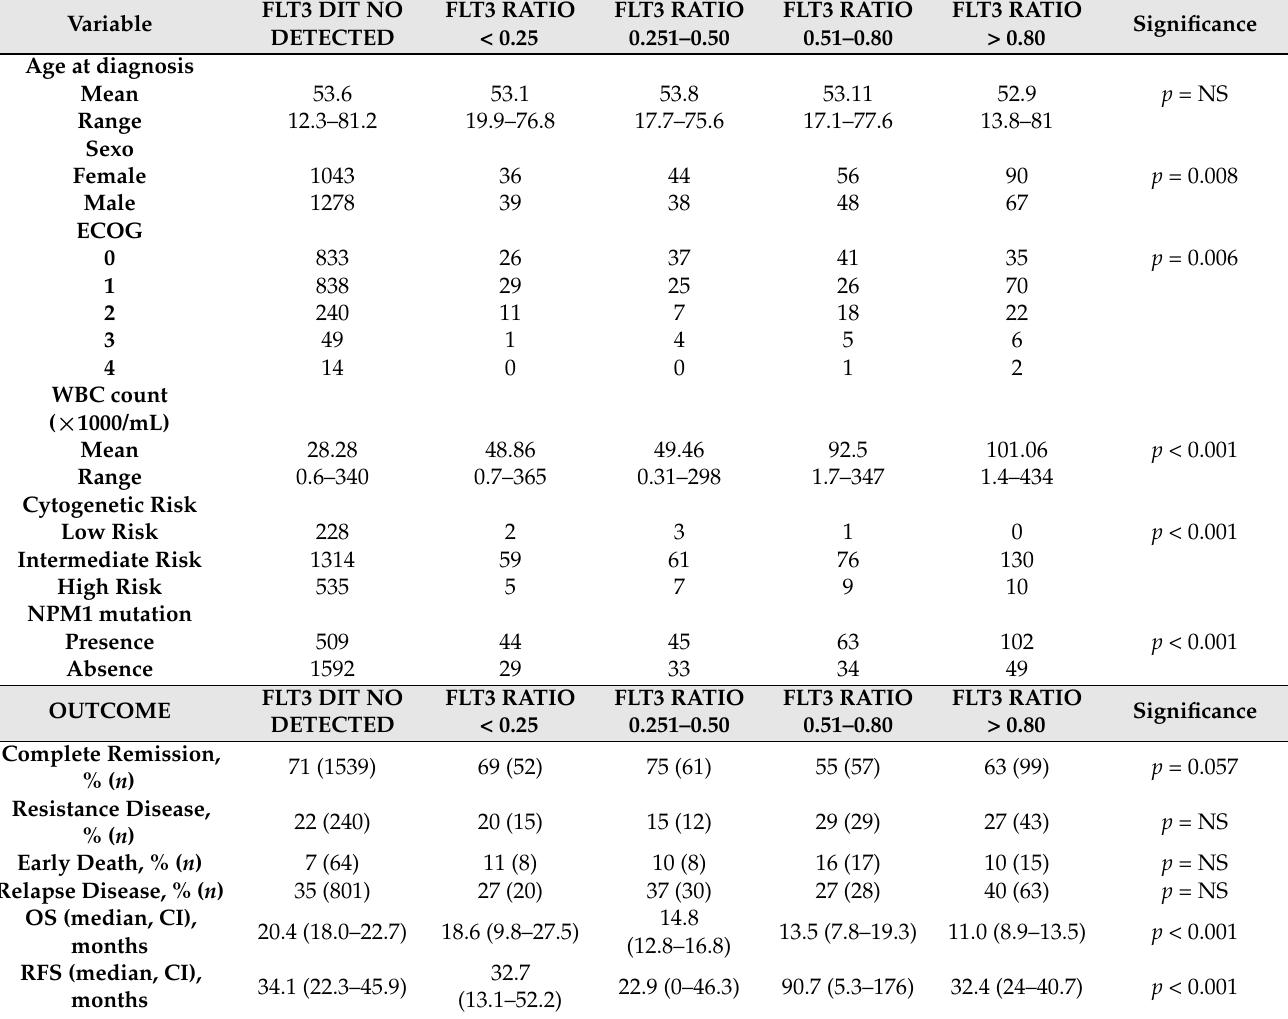
Table 1. Description of the characteristics and outcome of the patients with AML based on the levels of FLT3–ITD. A total of 2901 adult patients who enrolled in the consecutive multicenter AML PETHEMA trials and were included in the PETHEMA registry were evaluated. We separated FLT3–ITD ARs into 4 increasing intervals according to a previous study in order to facilitate the understanding of the results. Abbreviations: ECOG, Eastern Cooperative Oncology Group status performance; WBC, white blood cell; cytogenetic risk based on MRC classification; OS, overall survival; RFS, relapse-free